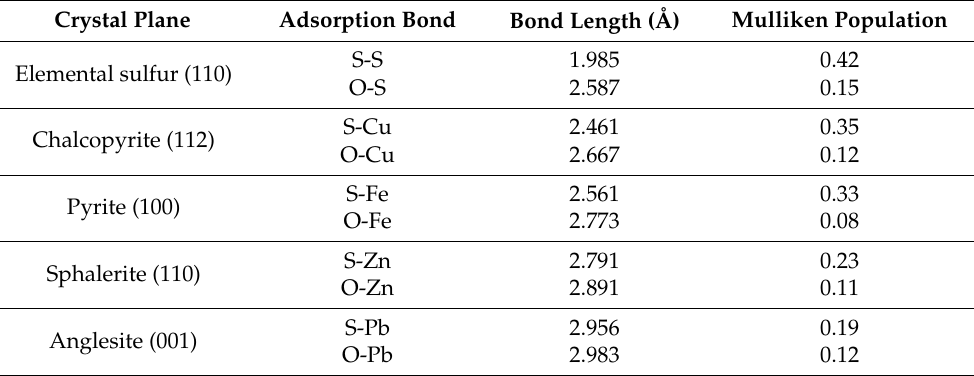
Figure 10. The steadiest adsorption configurations of IPETC on perfect crystal planes of chalcopyrite (112) ( a ), pyrite (100) ( b ), sphalerite (110) ( c ) and anglesite (001) ( d ). Table 12. Mulliken population of adsorption bonds of each steadiest adsorption configuration of IPETC on each crystal